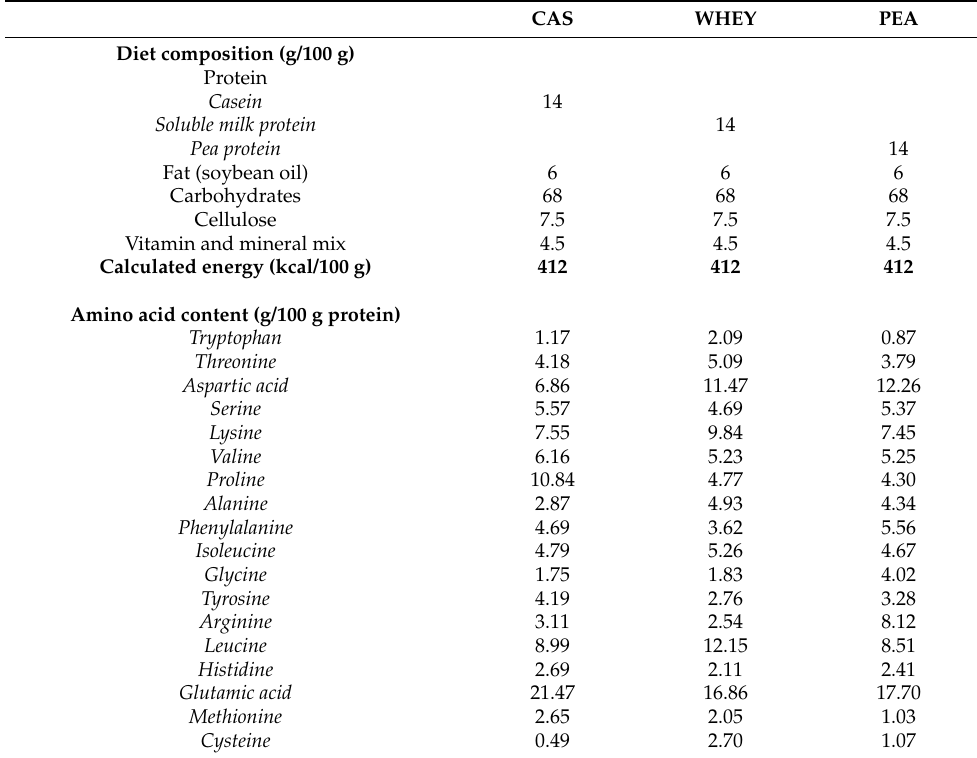
Table 1. Experimental diet: composition and amino acid content.